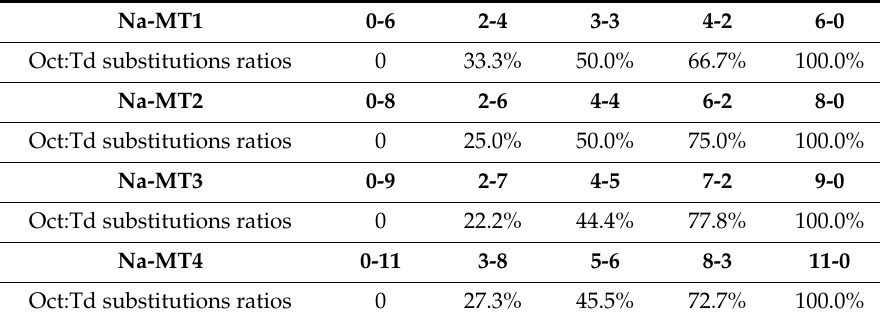
Table 1. The ratio of octahedron:tetrahedron (Oct:Td)